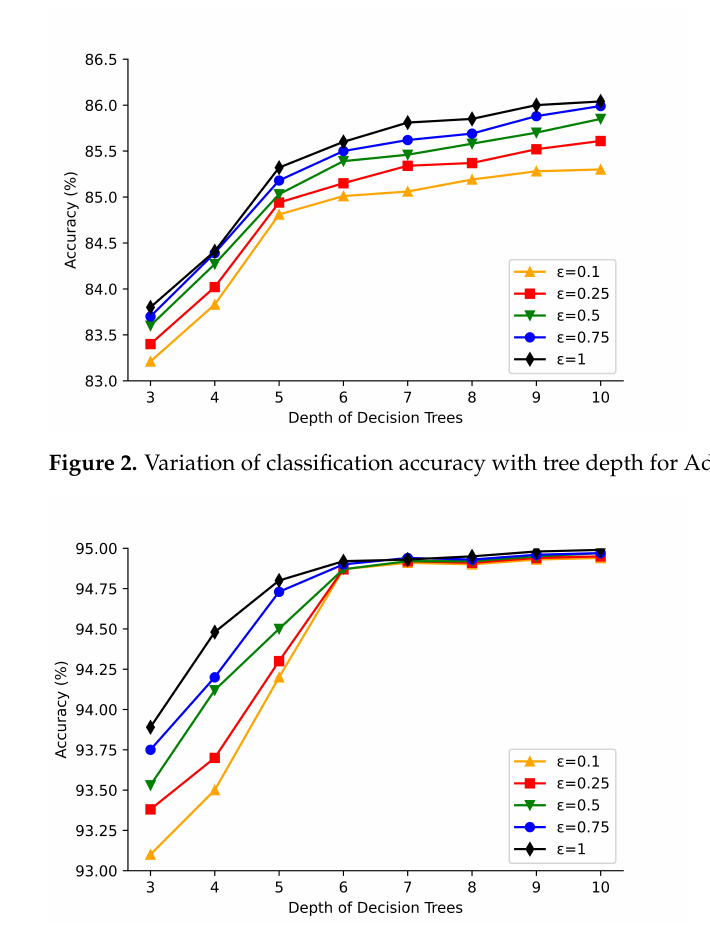
Figure 3. Variation of classification accuracy with tree depth for Mushroom dataset.